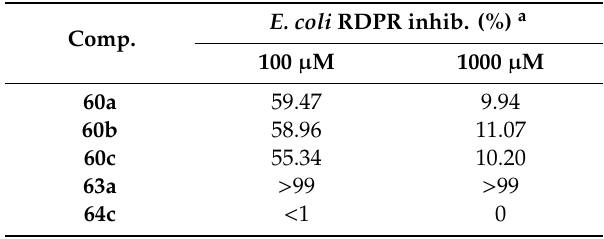
Table 25. The inhibitory activity of purine and butenolide conjugates toward Escherichia coli ribonucleotide diphosphate reductase (RDPR) enzyme.